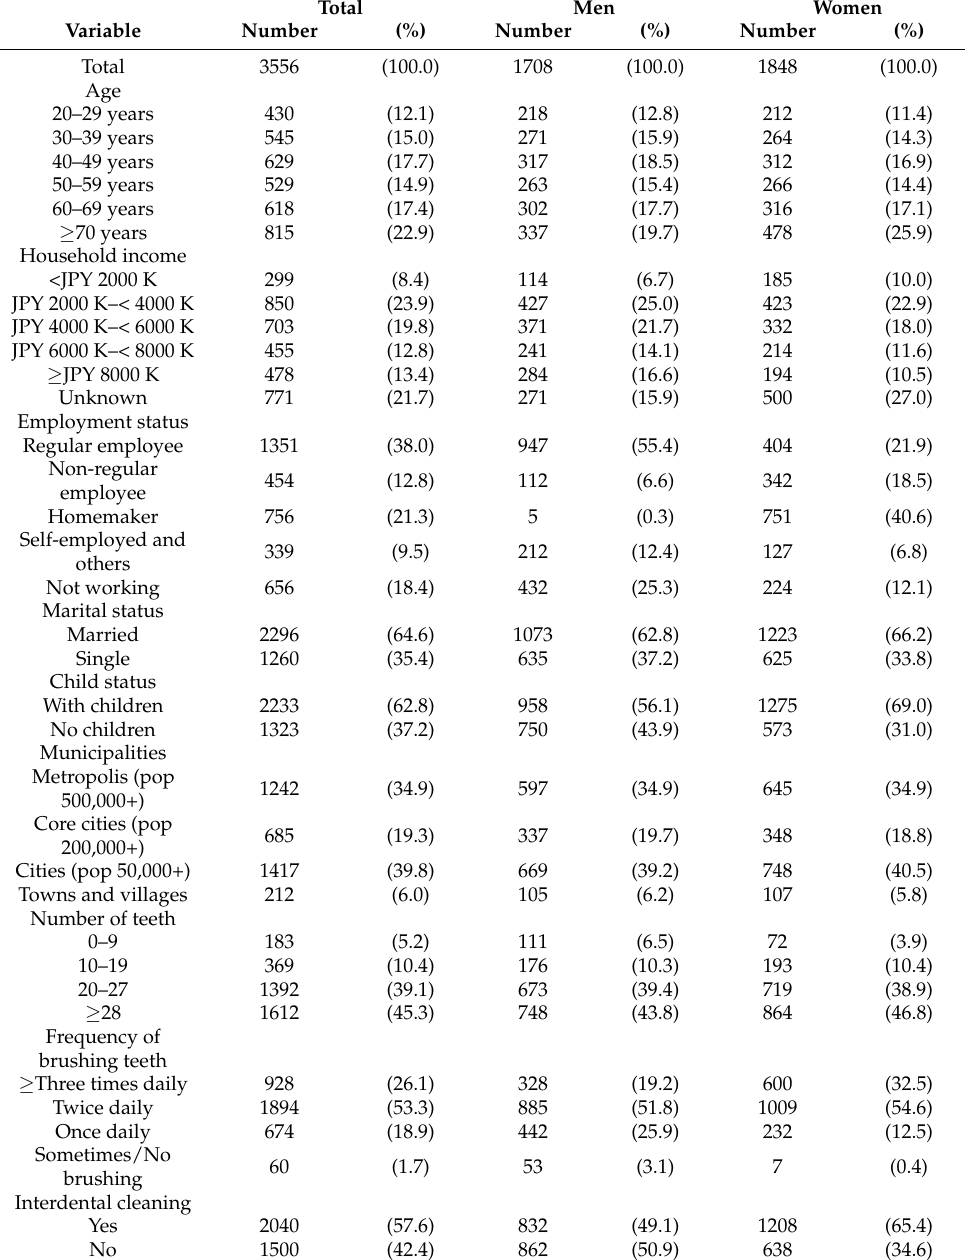
Table 1. Characteristics of the study